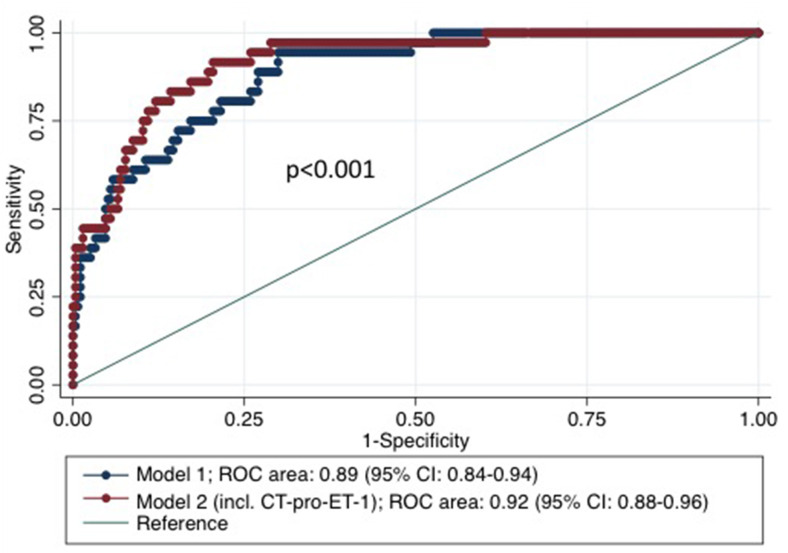
Receiver Operator Characteristic (ROC)-curves based on regression models for mortality within 3 months after stroke with and without CT-pro-ET-1. Model 1 represents the cox proportional hazards model for mortality within 3 months after stroke including the risk factors age and NIHSS on admission. Model 2 represents the analysis adding CT-pro-ET-1 on day 1 after admission to the model.